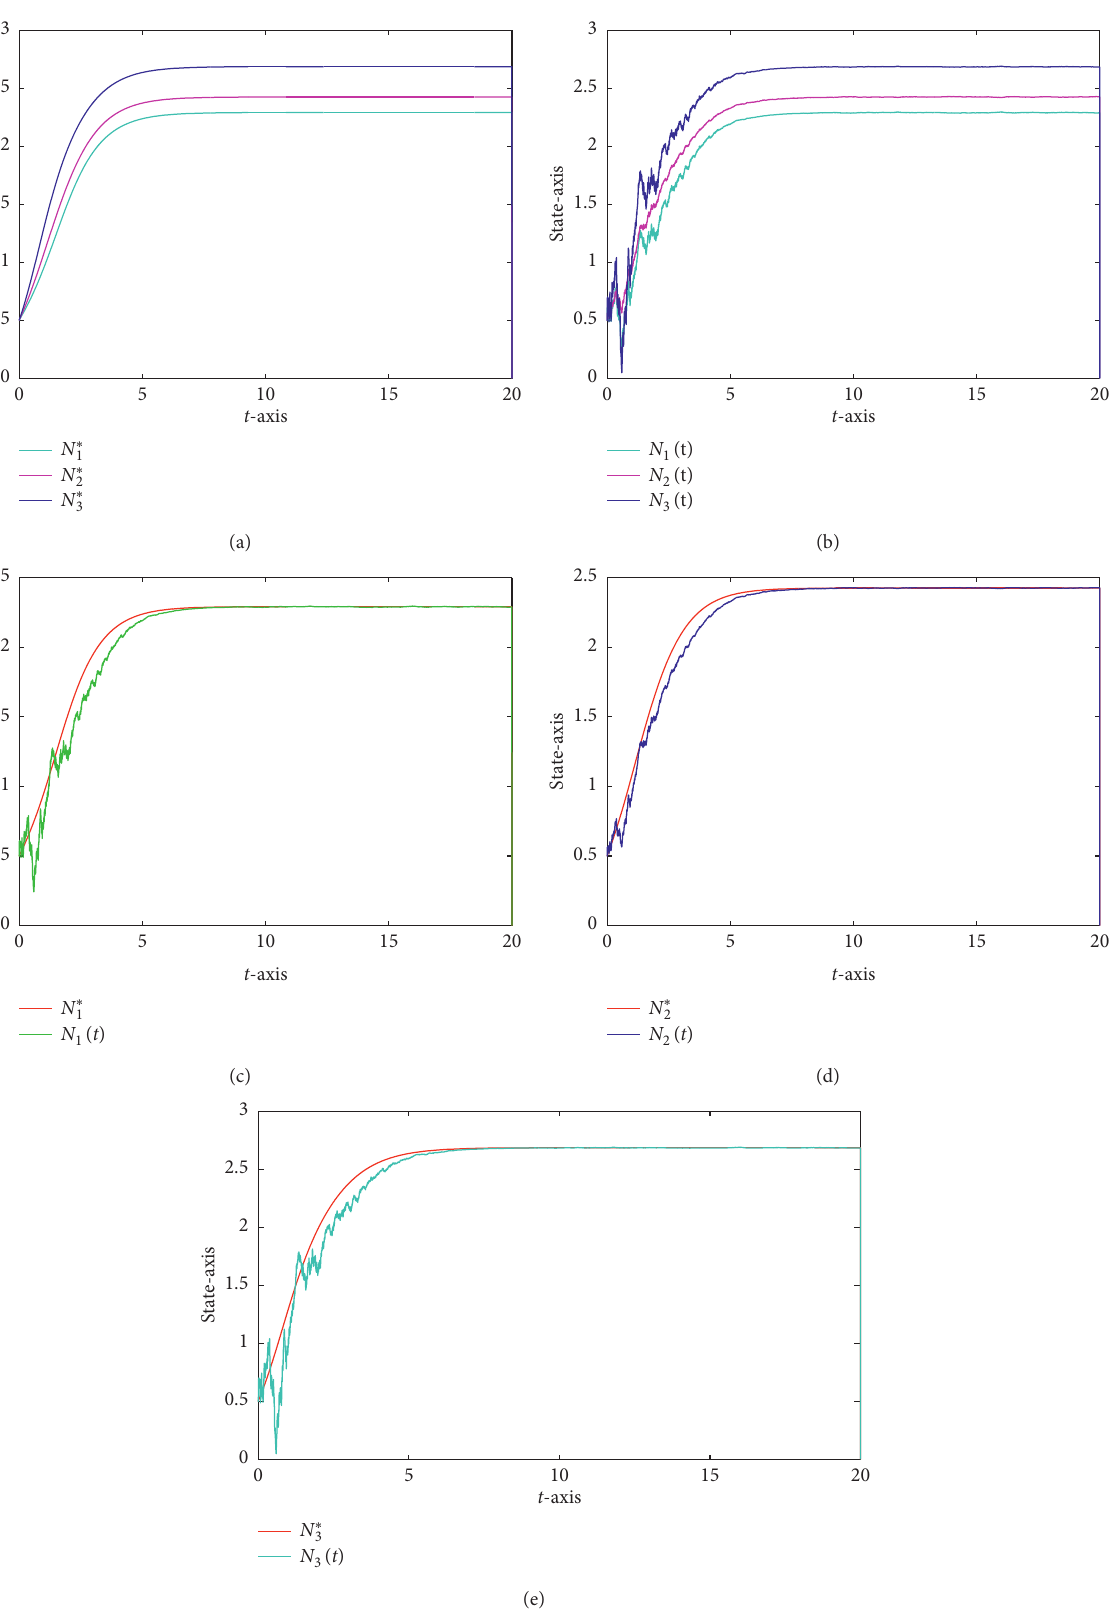
� 0 . 2 , σ � 0 . 1 , σ � 0 . 3 , and τ � 0 . 5: (a) equilibrium of (1) with N ∗ 1 2 3 , N ∗ , and N ∗ , 1 2 3